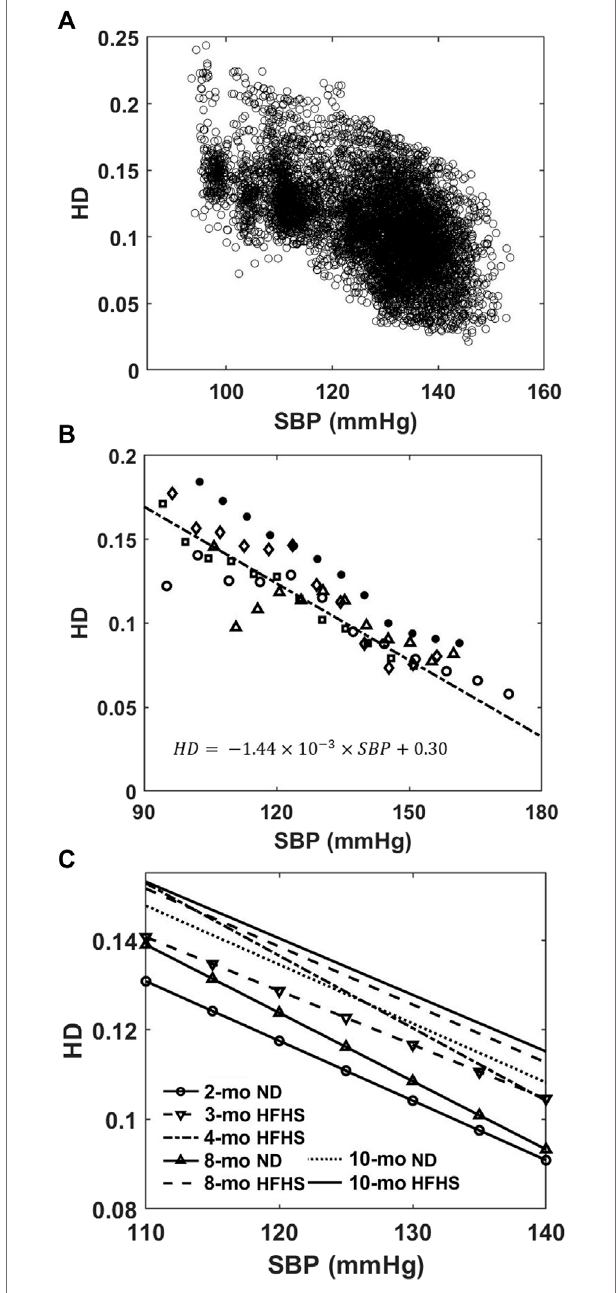
FIGURE 4 | (A) HD values of individual BPW are plotted as a function of the corresponding wave ’ s SBP. (B) Mean HD values within evenly spaced BP bins for the 8-months ND group ( n = 5). Different symbols represent different mice in the group. The solid line represents a weighted linear regression ( r 2 = 0.78) tothe data from the group. (C) Linear regressions between HD and luminalSBPforthe7ageanddietgroups.Thelinearrelationshipsconsistently trend upward with increasing age and HFHS